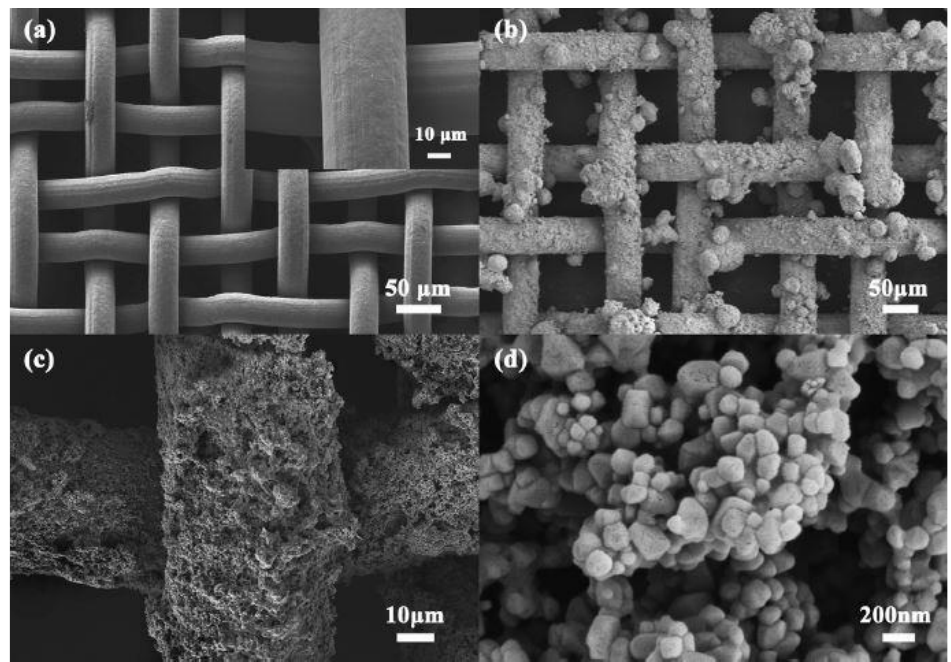
Figure 4. SEM images of ( a ) the original stainless-steel mesh and ( b – d ) the TiO 2 -coated mesh surface at low and high magnifications, respectively. Reprinted from Colloids and Surfaces A: Physico- chemical and Engineering Aspects, Volume 489, Jian Li, Long Yan, Wenfang Hu, Dianming Li, Fei Zha, Ziqiang Lei, Facile fabrication of underwater superoleophobic TiO 2 coated mesh for highly efficient oil/water separation, Pages No. 3, Copyright (2016), with permission from Elsevier [52].